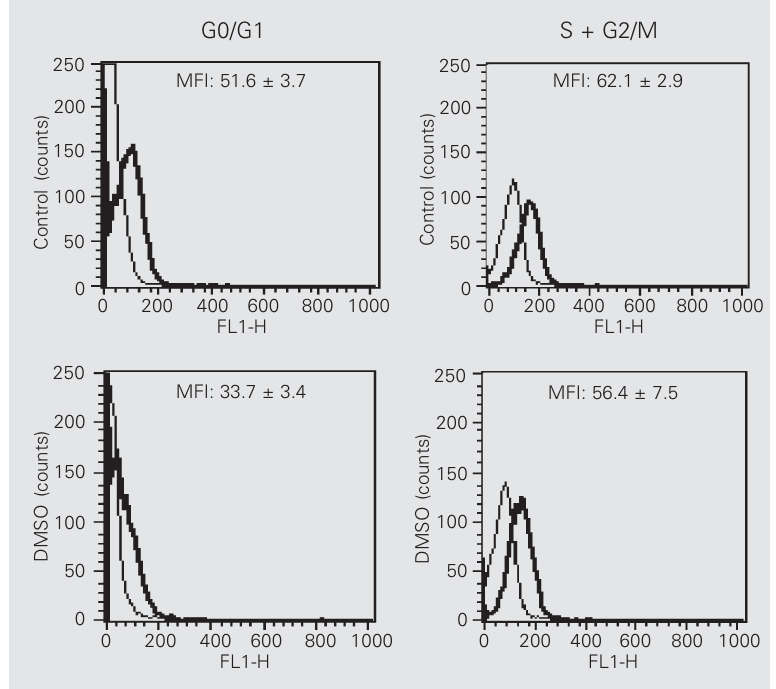
Figure 3. Dimethyl sulfoxide (DMSO) decreased expression of α 6 integrin in LISP-1 cells in G0/G1 but not in S + G2/M. Expression of α 6 integrin as a function of cell cycle phase was determined as described in Methods. The fine line and thick line correspond to the background and integrin expression, respectively. Fluorescence data are the mean ± SD for 4 independent experiments. MFI = mean fluorescence intensity.